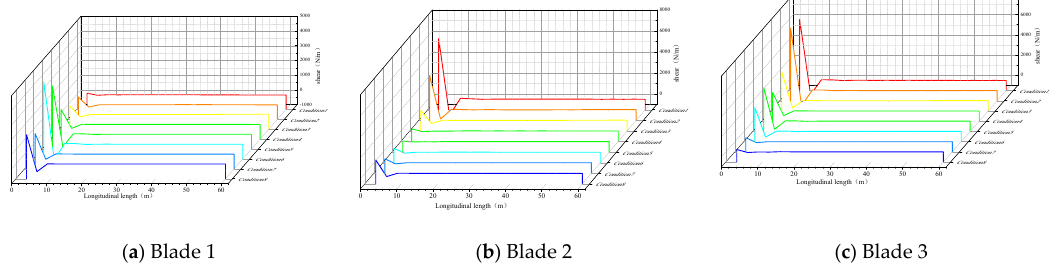
Figure 28. Distributions of mean shearing force on blades under different conditions.